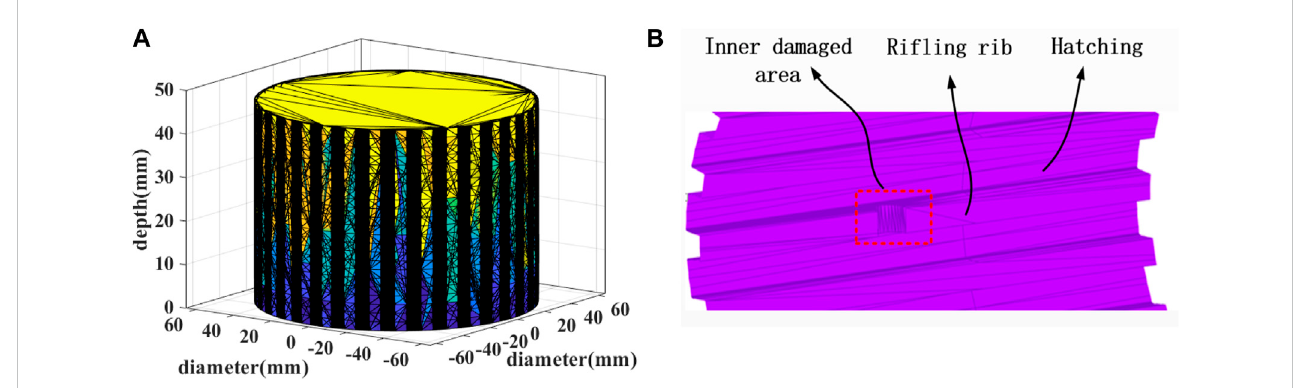
FIGURE 4 Three-dimensional reconstruction based on Delaunay triangulation. (A) Section of the barrel reconstruction model. (B) Damaged area